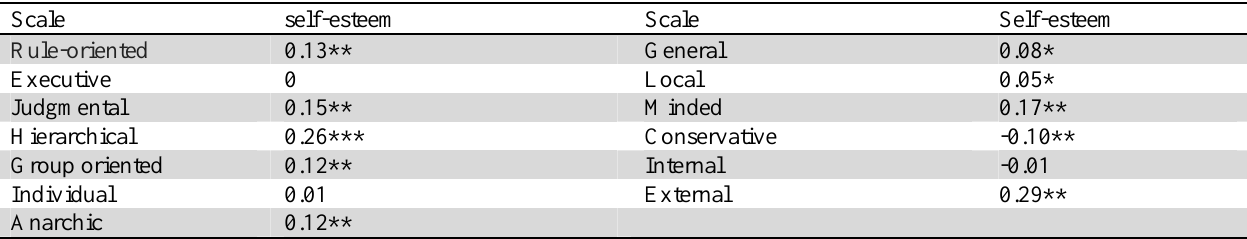
The correlation ratios between age and style of thinking Scale self-esteem Scale